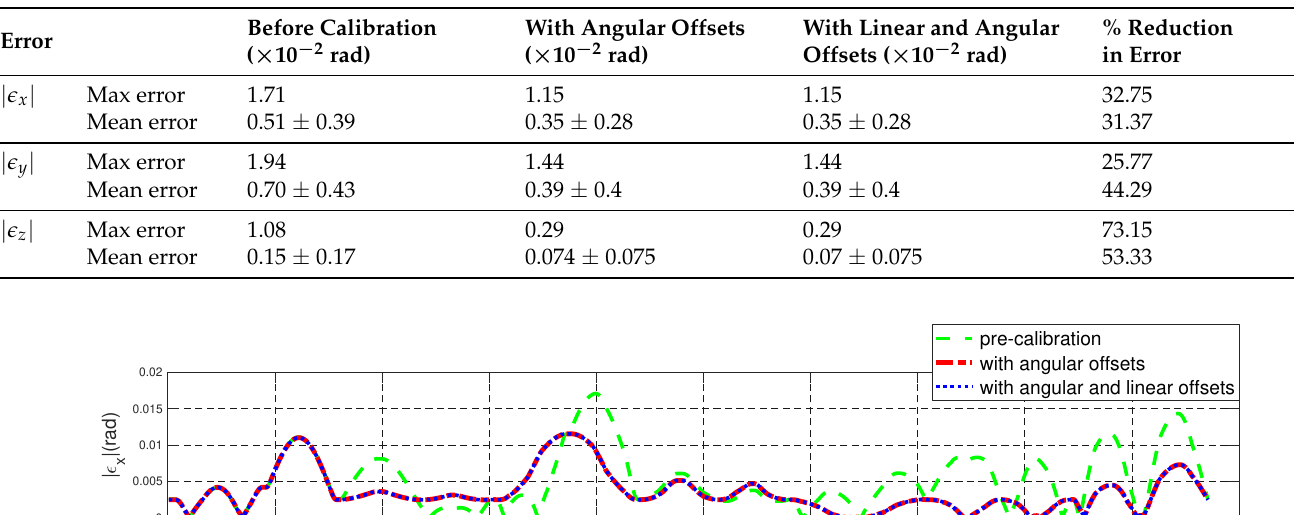
Table 5. Resultant orientation error before and after calibration.